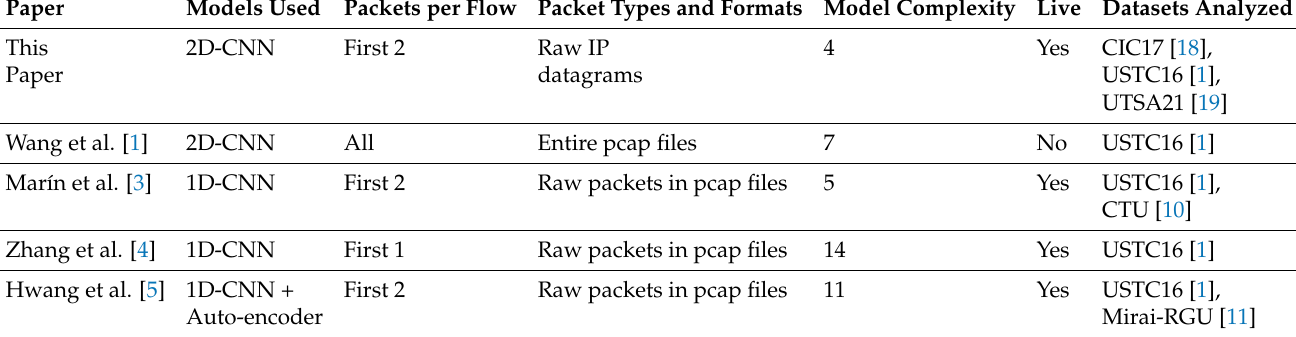
Table 5. A comparison of our proposed model with related works using the USTC16 dataset. All works presented achieve approximately 100% balanced accuracy when analyzing this dataset alone. Model Complexity is reported as a measure of number of layers. The Live column indicates whether the proposed solution’s design allows for live analysis prior to the end of a